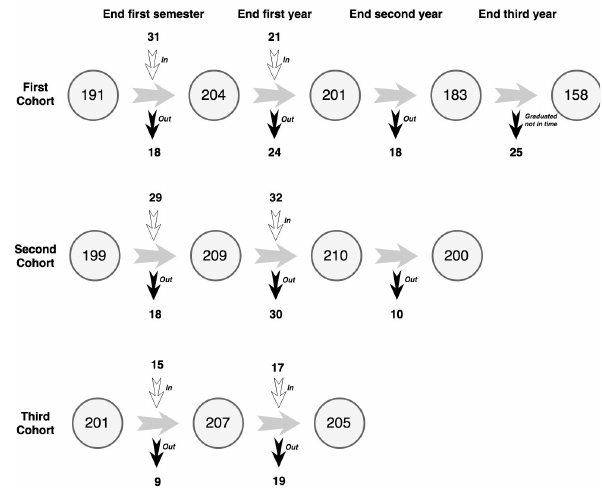
Fig. 5. Number of students involved step-by-step (in the circles), entering (white arrows) or leaving (black arrows) the